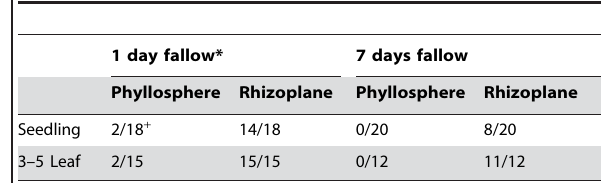
Table 1. Incidence of Salmonella enterica contamination following sowing in non-sterile soil mixed with contaminated plant debris from a previous tomato crop.